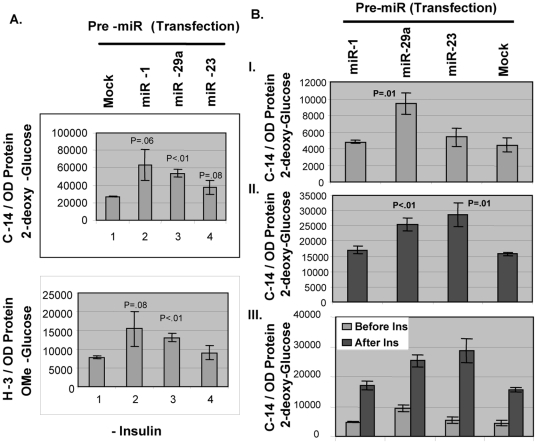
Mimic microRNAs miR-29a and miR-23 up-regulate the glucose transport activities in L6 SKM cell-line as insulin-independent and dependent manner respectively.A. Pre-miR transient transfection. 25 nM Pre-miRs were transfected in rat L6 cells according to the protocol as described in method section. 14C-labelled 2-deoxyglucose and 3H-labelled OMe-glucose were used as substrate along with the non-radioactive substrate (0.15 mM) for glucose transport activity as reversible and irreversible manner respectively. Cytochalasin B is not being added. B. Pre-miR transfection with Insulin. Same transfection experiments were done with cytochalasin B (10 µM) added in the transport reaction in presence and absence of 50 nM insulin. Glucose transport assay was performed just (I) before and (II) after adding insulin. (III) Panel was drawn to see the comparison before and after the insulin addition for each mimic precursor microRNA with respect to the control transport of 14C-labelled 2-deoxyglucose.